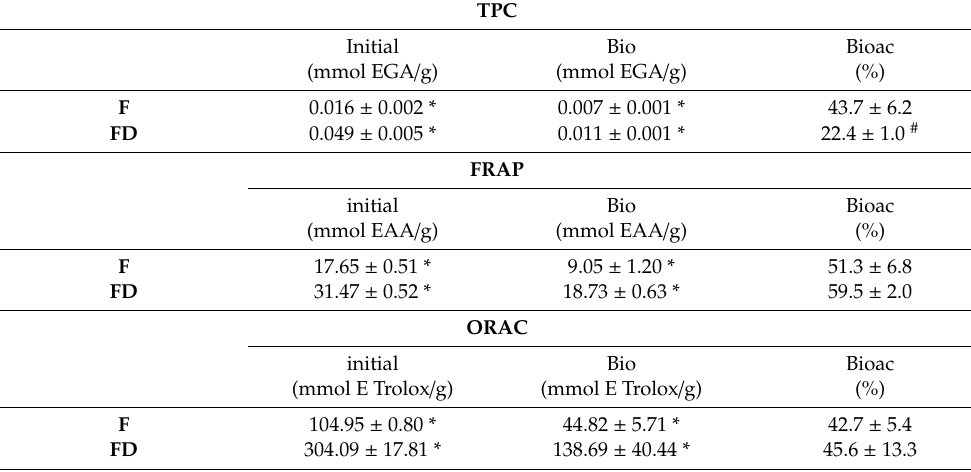
Table 2. Total phenolic content (TPC) and antioxidant activity of fresh (F) and freeze-dried (FD) seaweed: ferric reducing antioxidant power (FRAP) and oxygen radical absorbance capacity